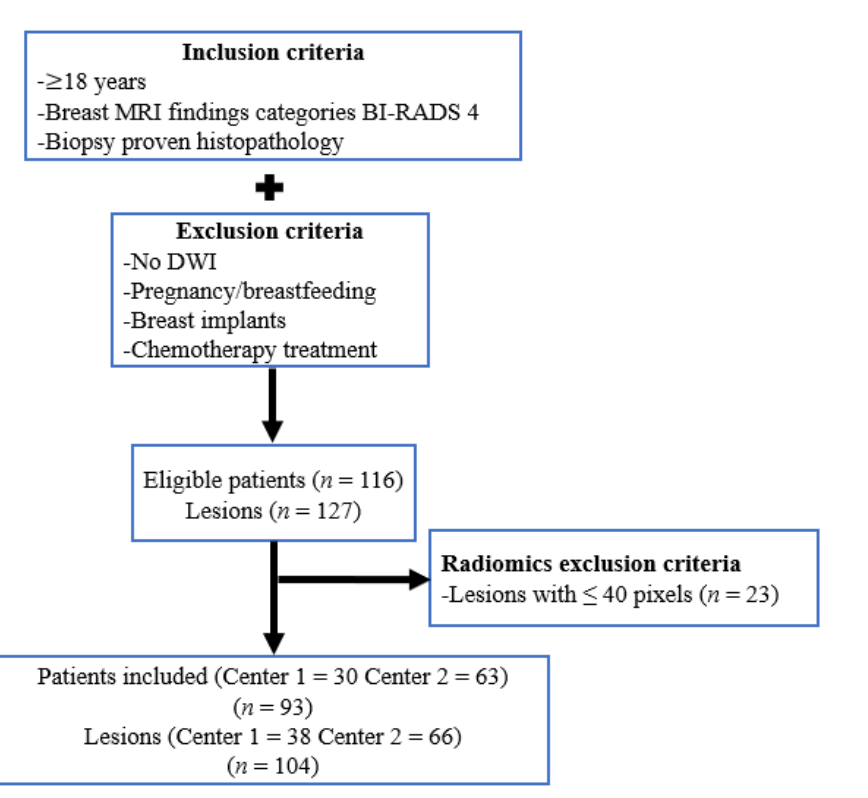
Figure 1. Flowchart for the study. BI-RADS, breast Imaging-Reporting and Data System; DWI, diffusion-weighted imaging.